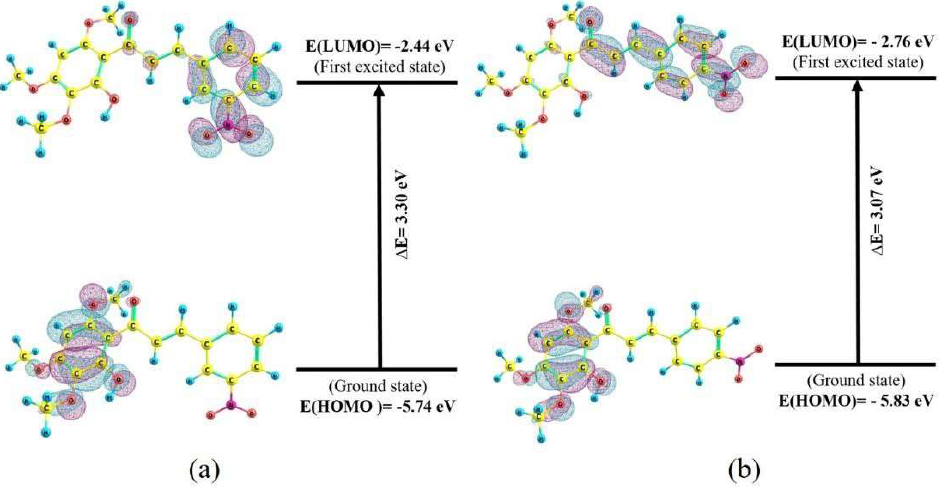
Figure 4. HOMO and LUMO molecular orbitals for chalcone 1 ( a ) 2 ( b ).